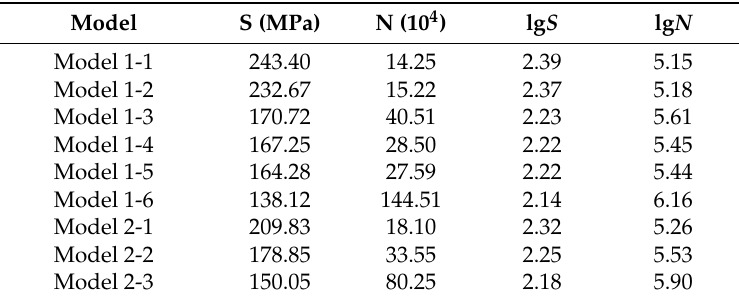
Table 2. Fatigue test